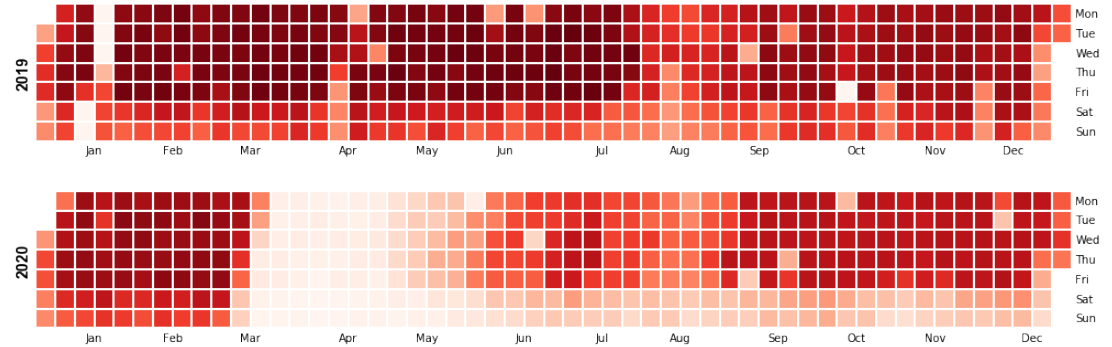
Figure 6. Calendar heatmap showing the number of daily trips made during 2019 and